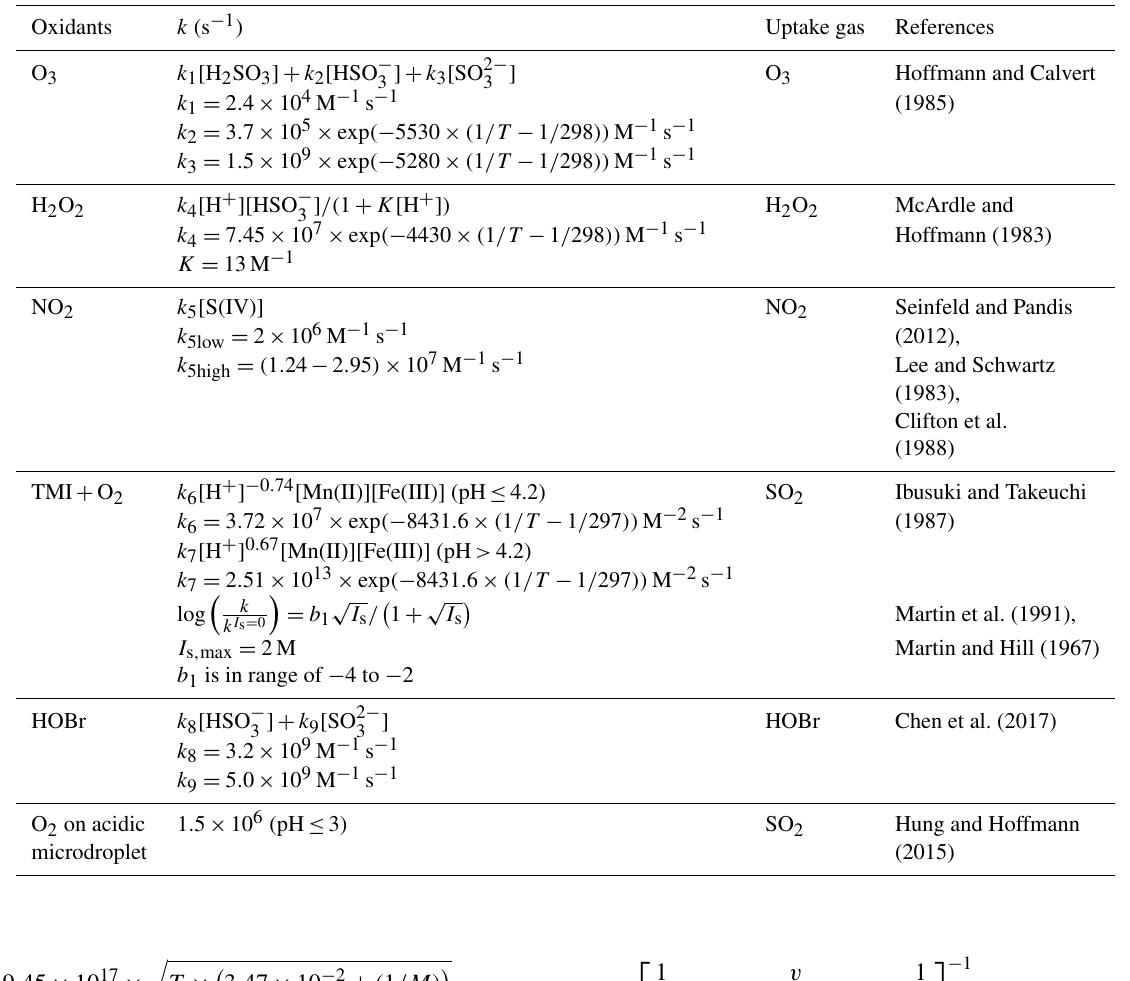
Table 2. Aqueous-phase reaction rate expressions, rate constants ( k ), and the influence of ionic strength ( I s ) on the first-order aqueous-phase sulfate production in